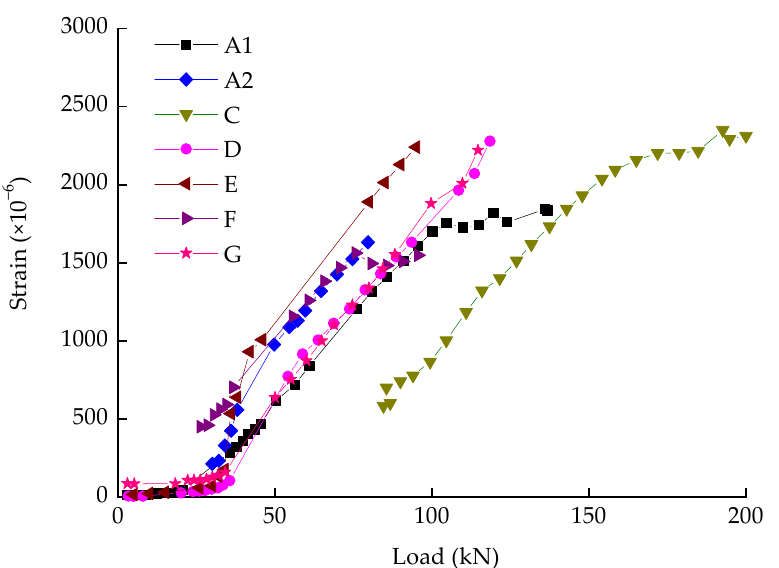
Figure 6. Load-strain curves of beams.